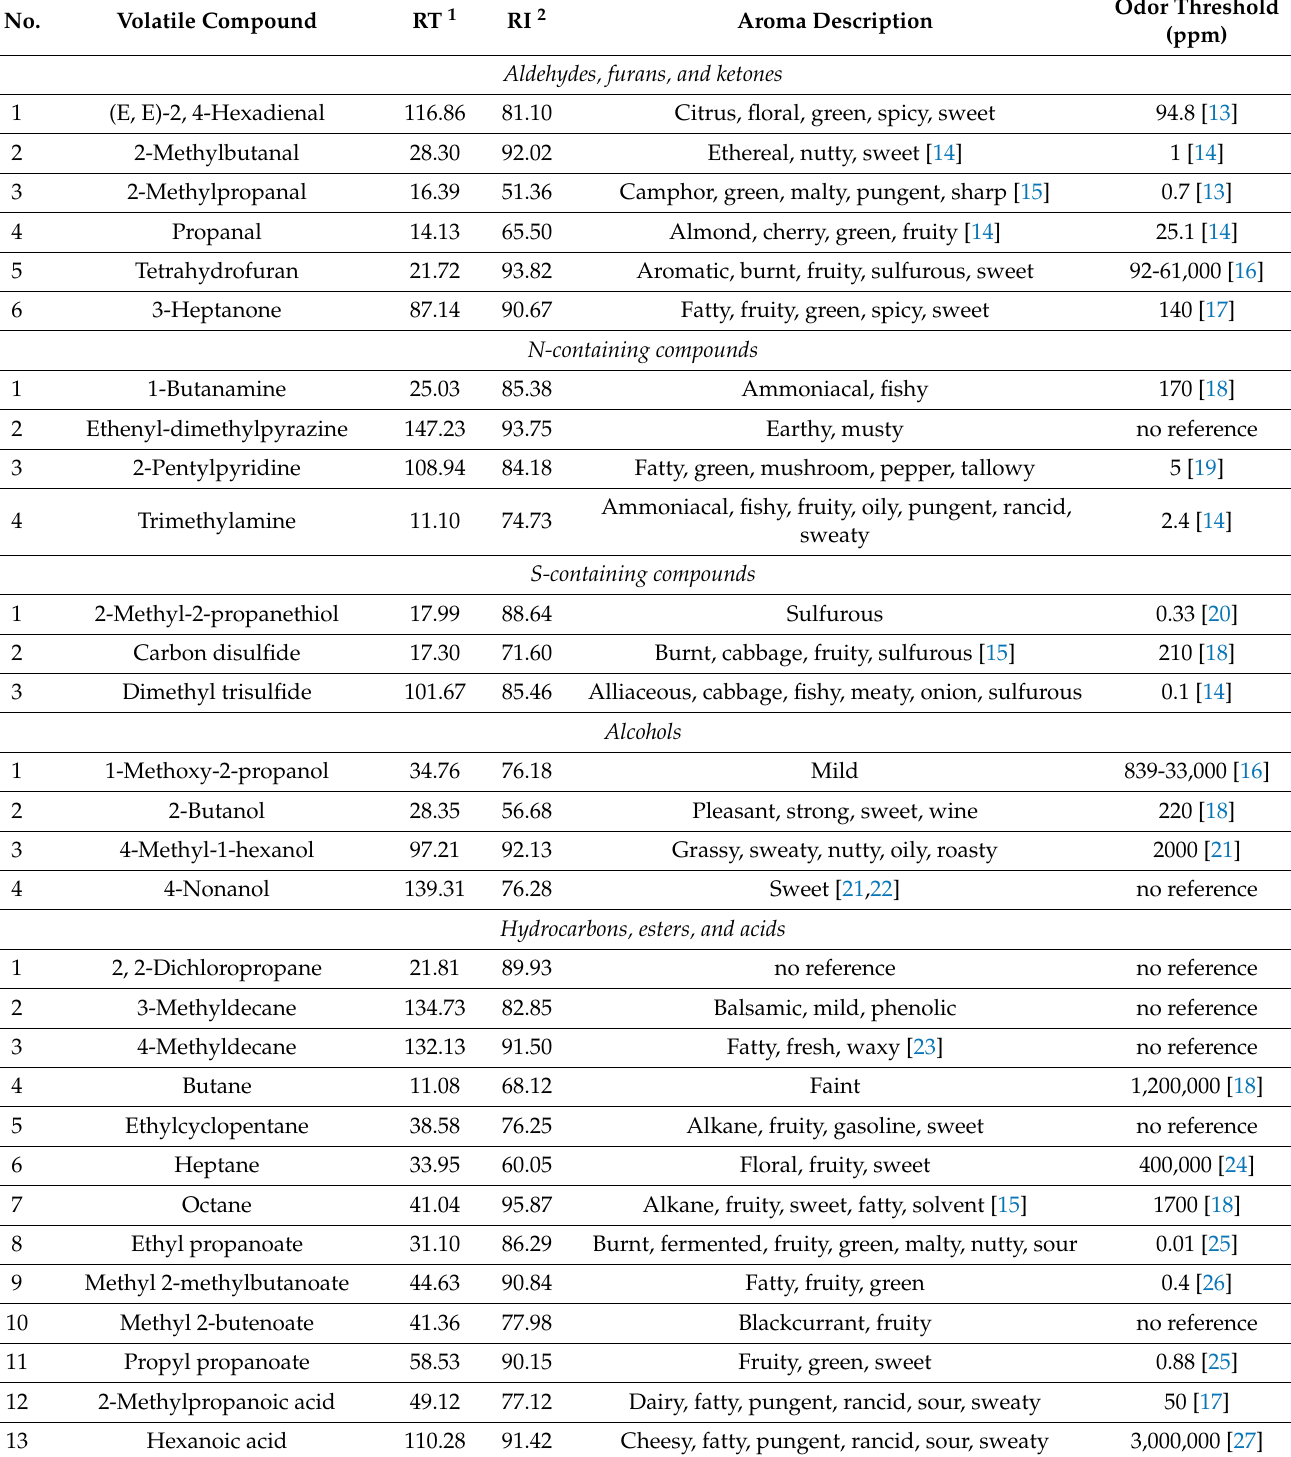
Table 2. Identified volatile compounds in dry- or wet-aged beef strip loins during 28 days of